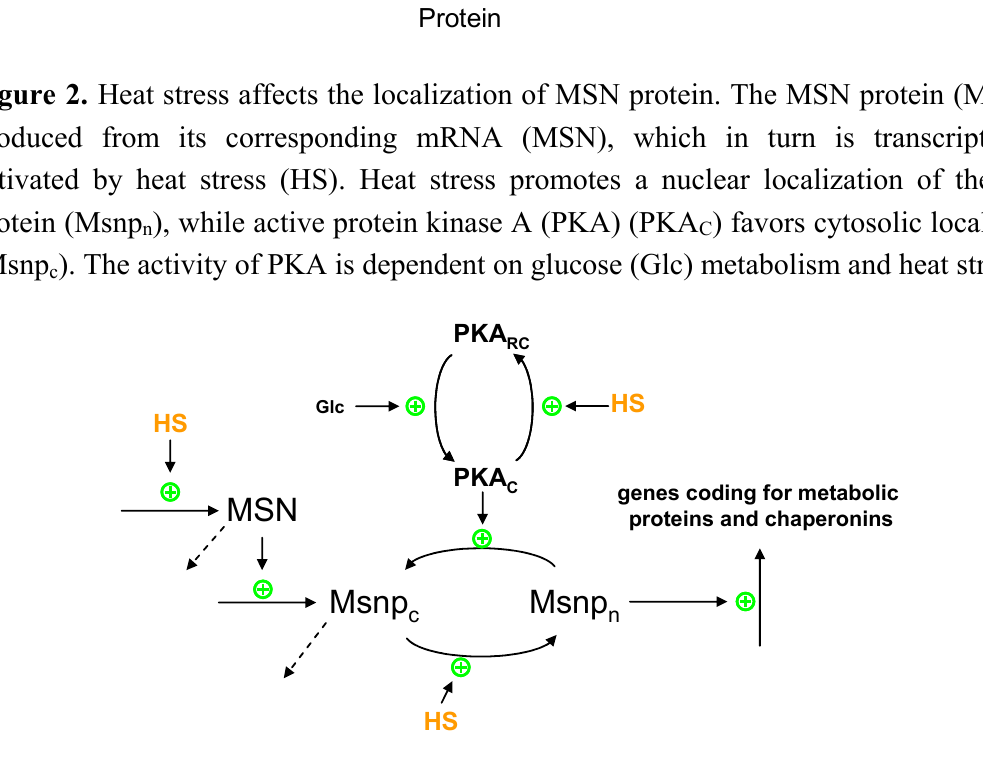
) favors cytosolic localization C